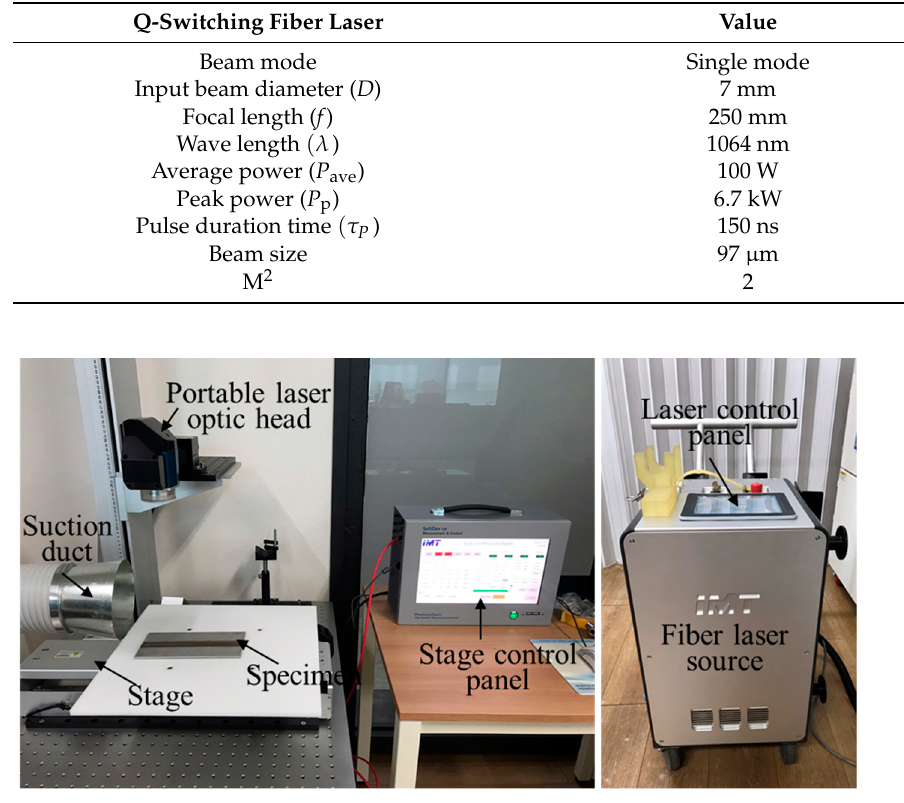
Figure 1. Experimental equipment and setup for laser cleaning. Table 1. Chemical compositions of STS316L.